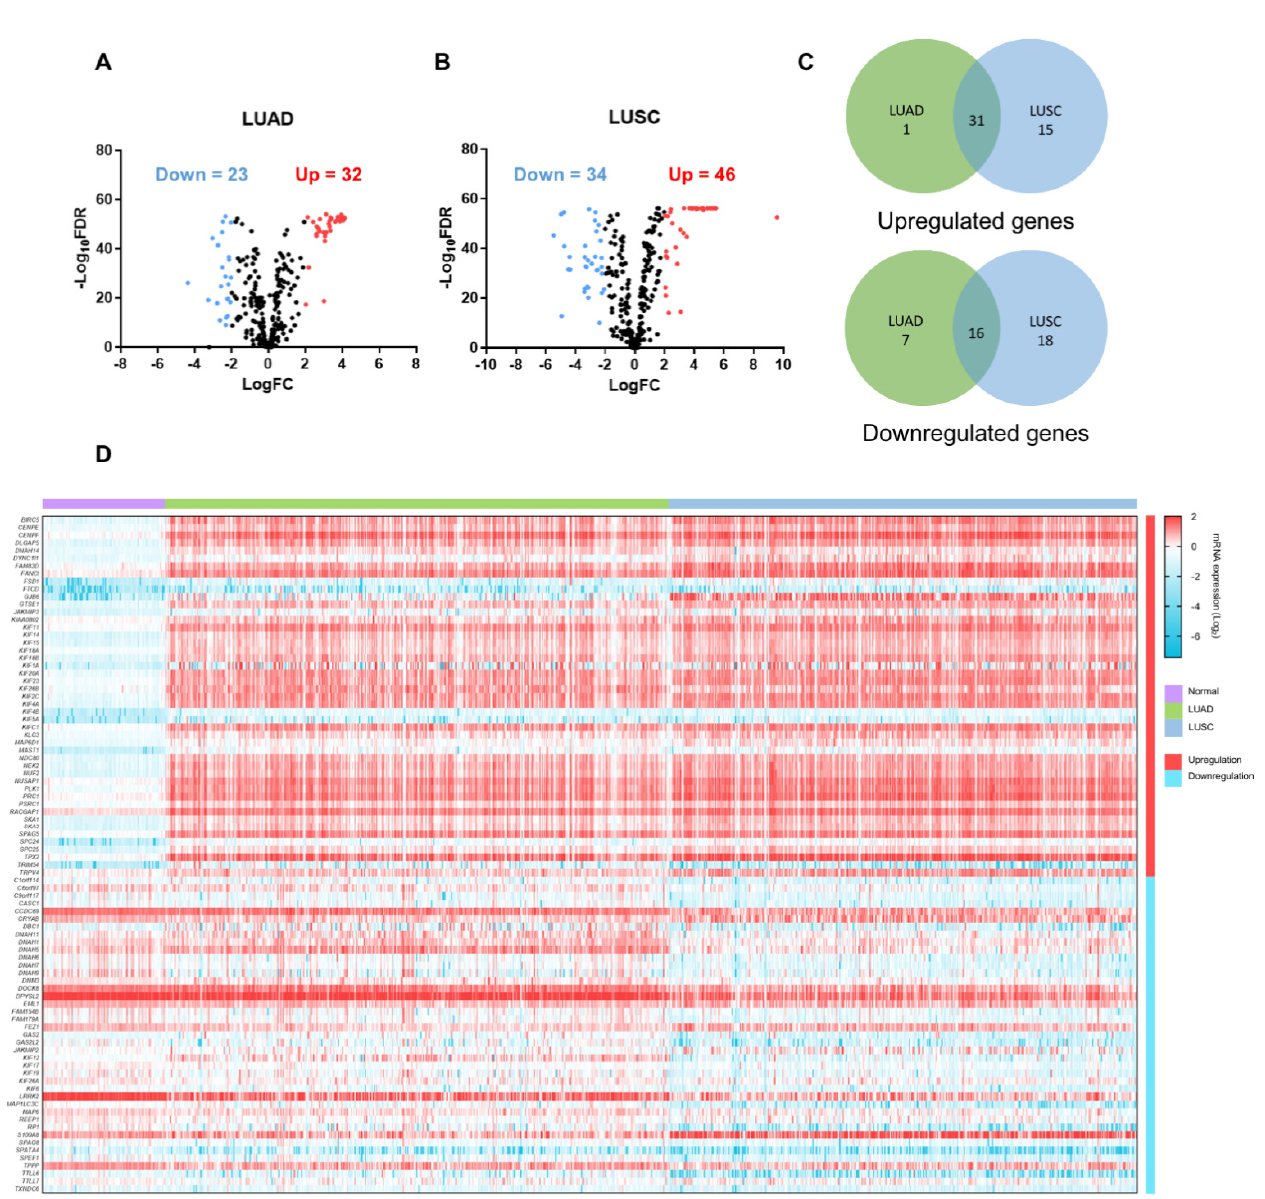
Figure 2. Differentially expressed MAP genes (DEMGs). Volcano plots depict the DEMGs in ( A ) lung adenocarcinoma (LUAD) and ( B ) lung squamous cell carcinoma (LUSC). Red indicates upregulated genes with log fold change (log 2 FC) > 2; blue indicates downregulated genes with log 2 FC < − 2, false discovery rate (FDR) < 0.05. ( C ) Venn diagrams represent the intersection of upregulated or downregulated genes between LUAD and LUSC. ( D ) Heatmap represents the mRNA expression (log 2 ) of the DEMGs in normal, LUAD, and LUSC